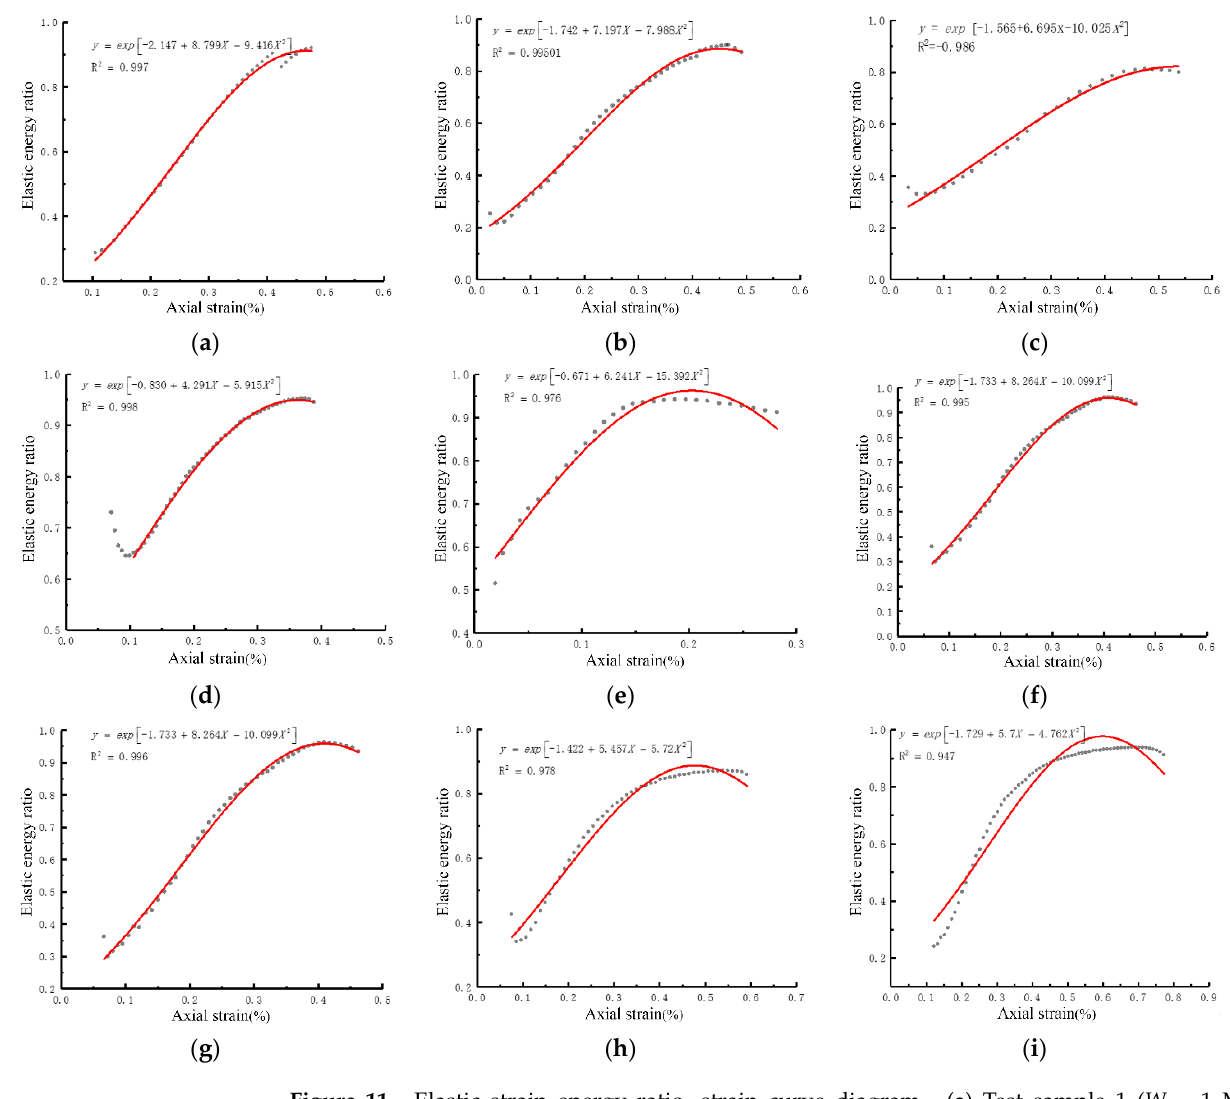
Figure 11. Elastic strain energy ratio, strain curve diagram. ( a ) Test sample 1 ( W = 1 MPa, S = 0.3 mm/min), ( b ) Test sample 2( W = 1 MPa, S = 0.6 mm/min), ( c ) Test sample 3 ( W = 1 MPa, S = 1.8